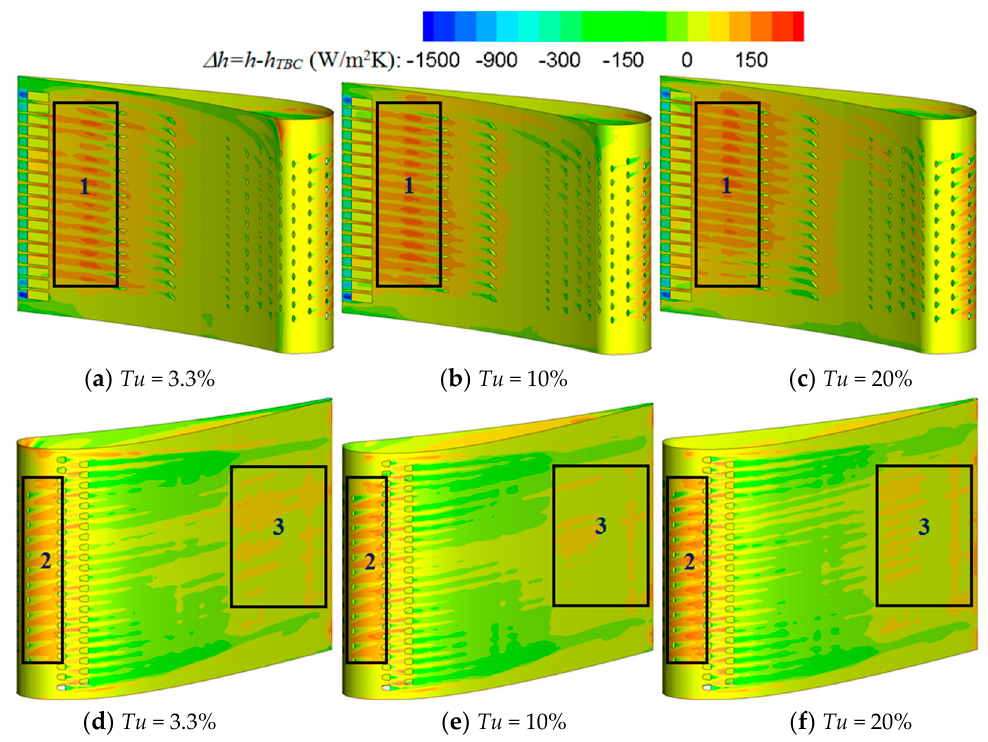
Figure 12. Effect of TBC on heat transfer coefficient ( a – c ) on the PS; ( d – f ) on the SS at three Tus .